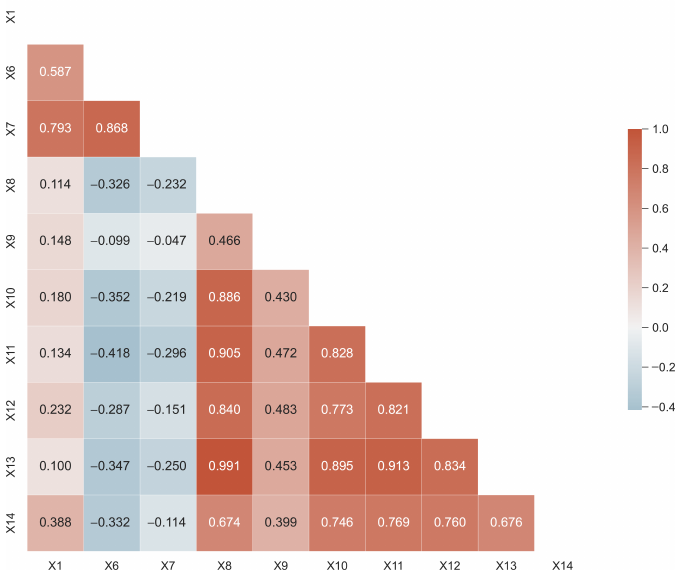
Figure 4. Correlation matrix of data